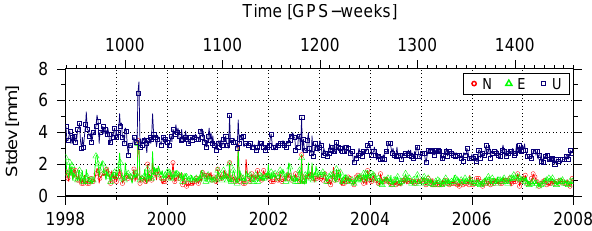
Fig. 3. Weekly overall mean of station coordinate repeatabilites.